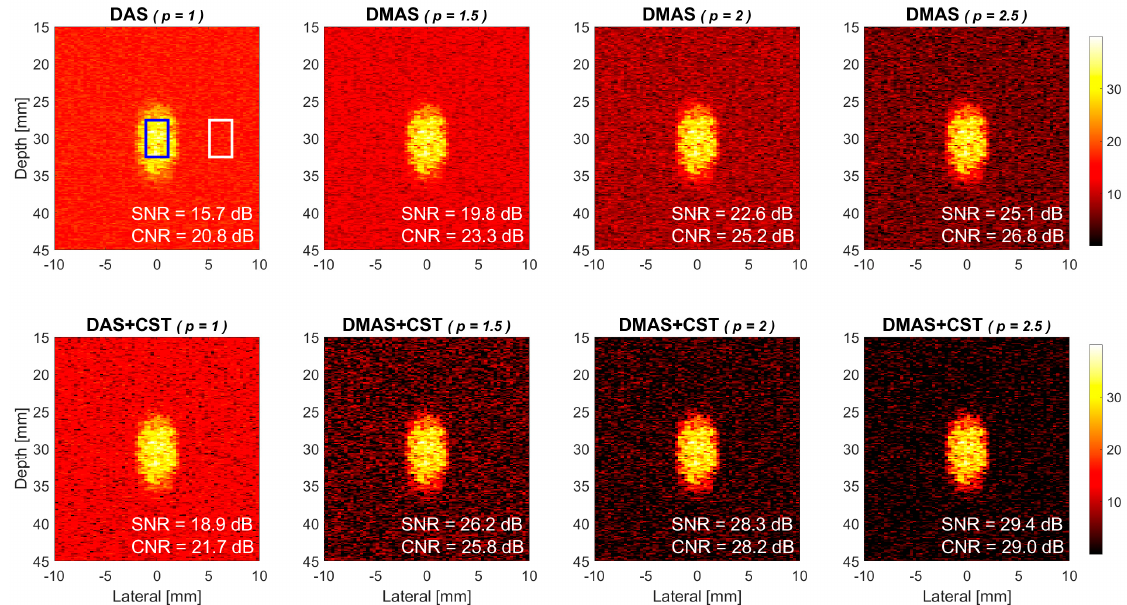
Figure 7. Simulated power Doppler images of flow phantom for DAS beamforming, DMAS beamforming with the p value of 1.5, 2.0 and 2.5, respectively from left to right. Five PW transmit angles are used (i.e., [ − 5° − 2.5° 0° +2.5° +5°]). Upper panels: without the CST technique. Lower panels: with the CST technique.